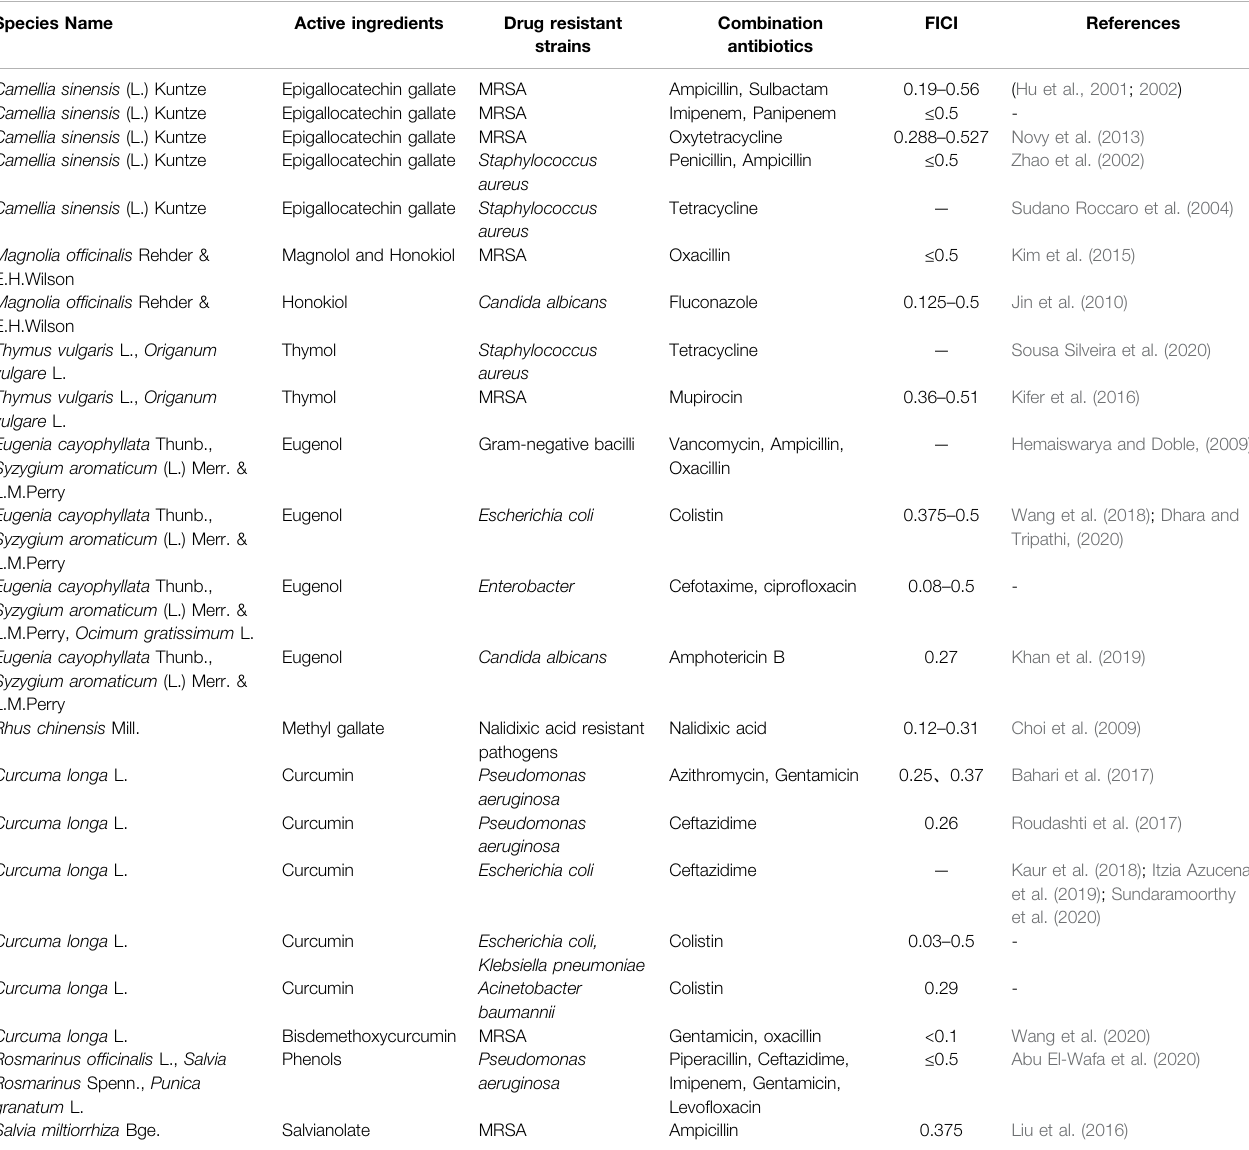
TABLE 3 | Summary of phenolic compounds in combination with